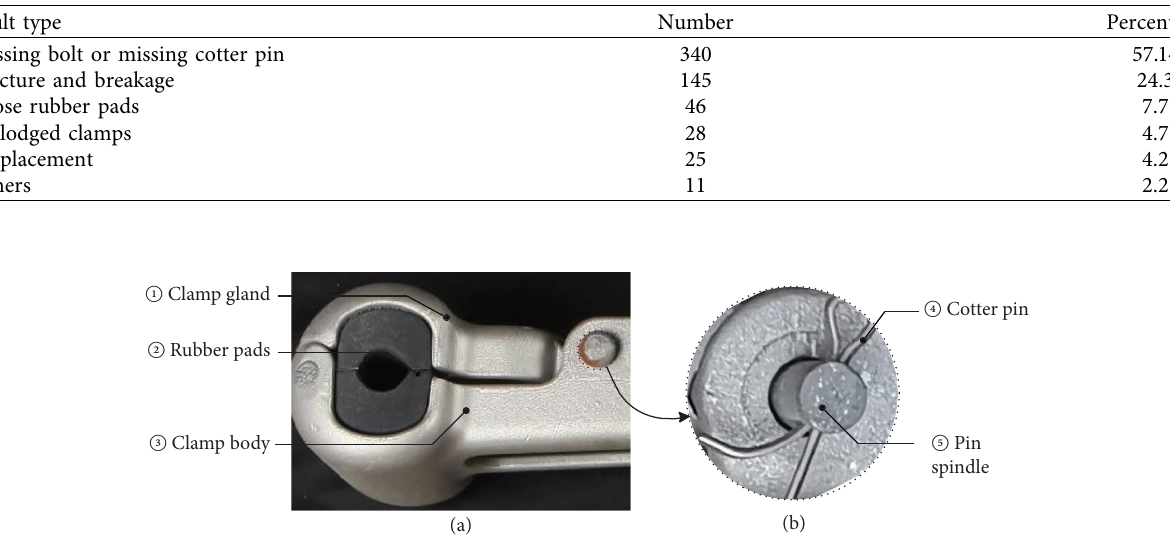
Figure 2: Structure of the regular spacer damper clamp: (a) clamp component composition and (b) structure composition of the clamp installation